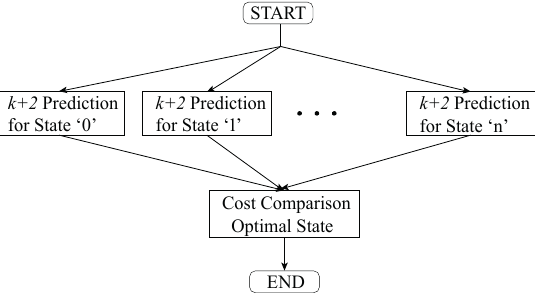
Figure 5. Flowchart of the Parallel Field-Programmable Gate Array (FPGA) Implementation for the Exhaustive Searching Algorithm (ESA).